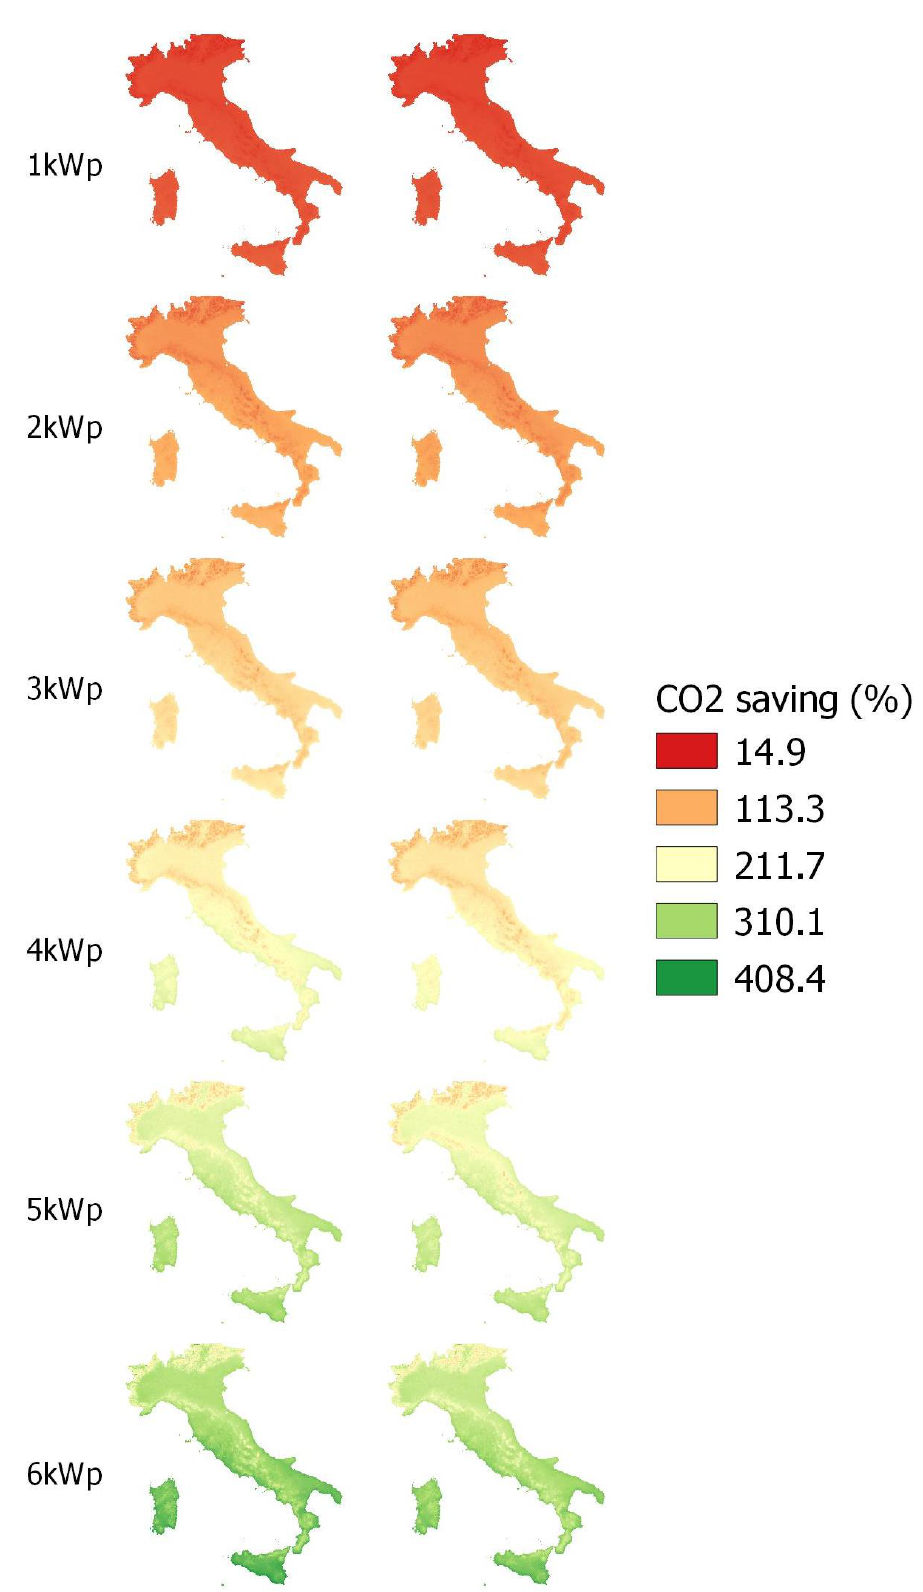
Figure A2. CO 2 saving for E L = 2700 kWh, left side without battery and right side with